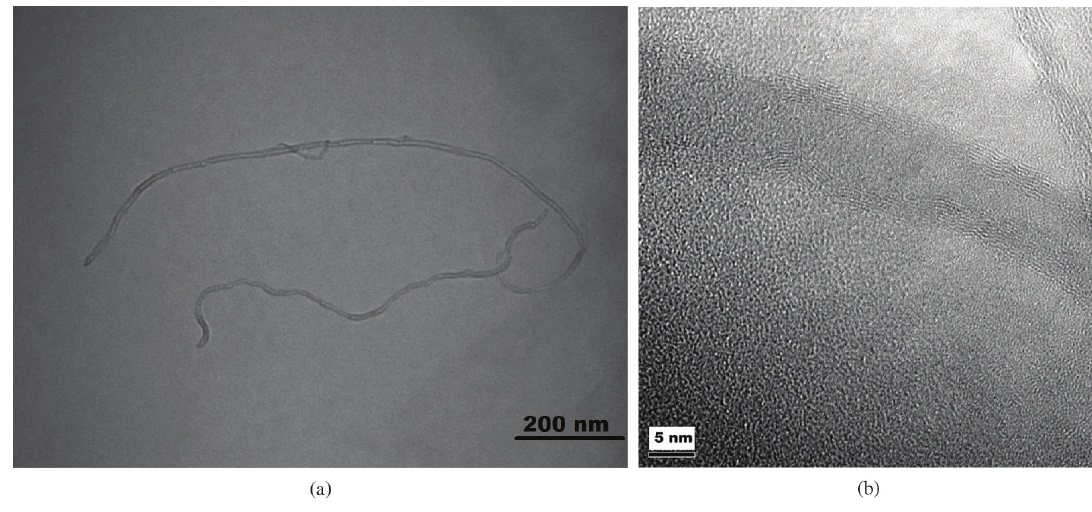
Figure 1. TEM images of pristine MWCNT used in the present work: A- Low magnification image showing their high aspect ratio: B- High magnification image, showing the graphene layers that form the tube wall.